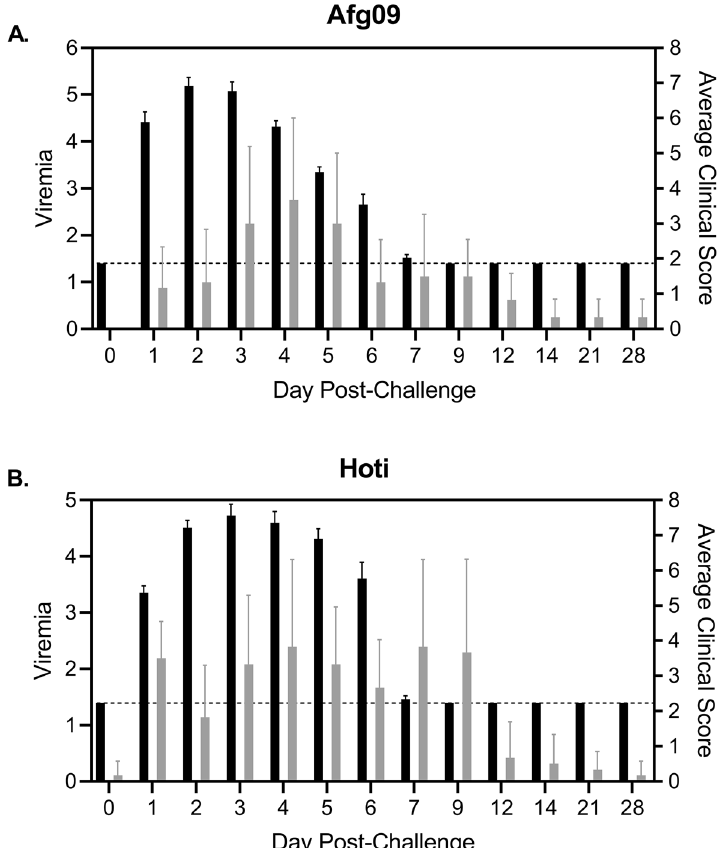
Figure 1. Viremia in NHPs for Afg09 and Hoti. Averaged challenge group viremia (black bars) and clinical scores (grey bars) for Afg09 ( A ) and Hoti ( B ). Whole blood viremia is expressed in PFU/mL (log10). Dashed lines indicate limit of detection for viremia assay. Error bars represent standard deviation. Aggregate NHP clinical data shown is from original study reported in 22